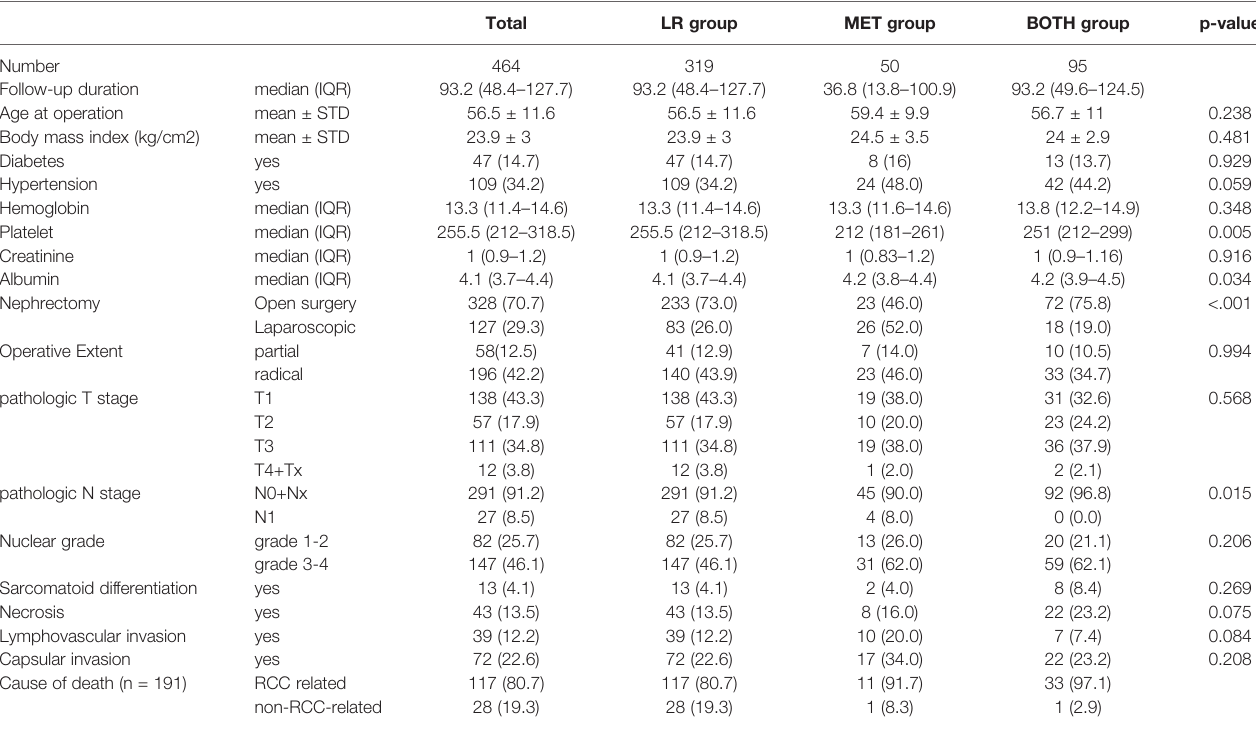
TABLE 1 | Baseline characteristics (N =